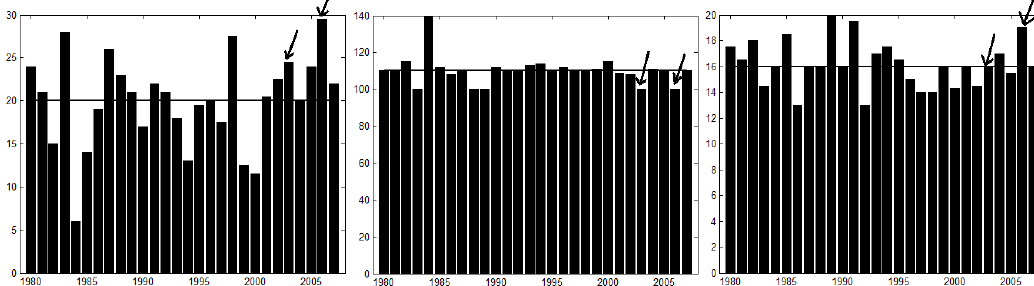
Fig. 4. The variation charts of the area index, the west ridge point index and the ridge line index of the SH in June from 1980 to 2007.